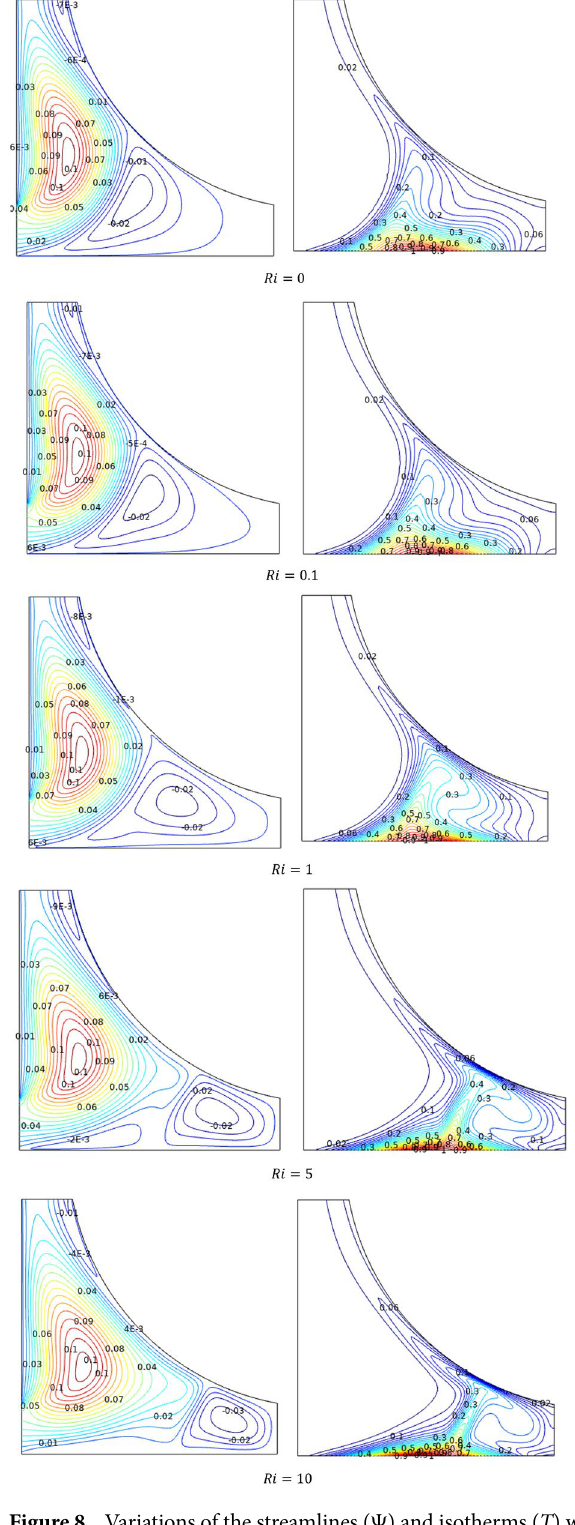
Figure 8. Variations of the streamlines ( (cid:31) ) and isotherms ( T ) with various Ri at configuration 1, Re = 1000 , Ha = 0 , ϕ = 0.02